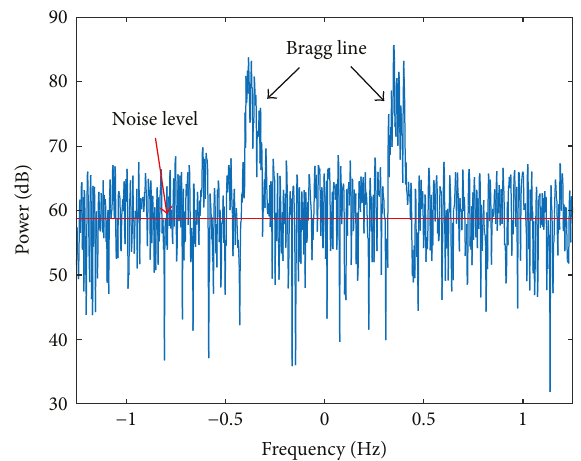
Figure 4: An example of the Doppler spectrum for monopole channel in the